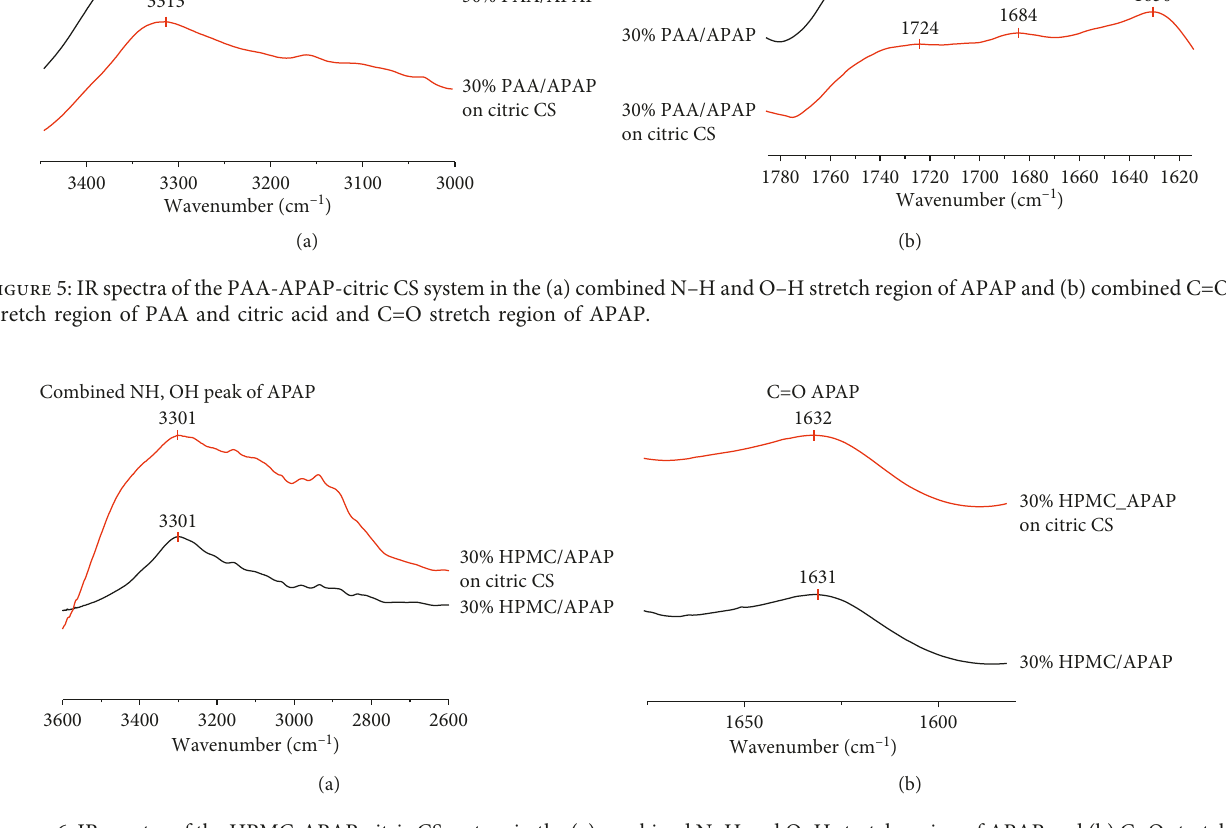
Figure 6: IR spectra of the HPMC-APAP-citric CS system in the (a) combined N–H and O–H stretch region of APAP and (b) C � O stretch region of citric acid and APAP.